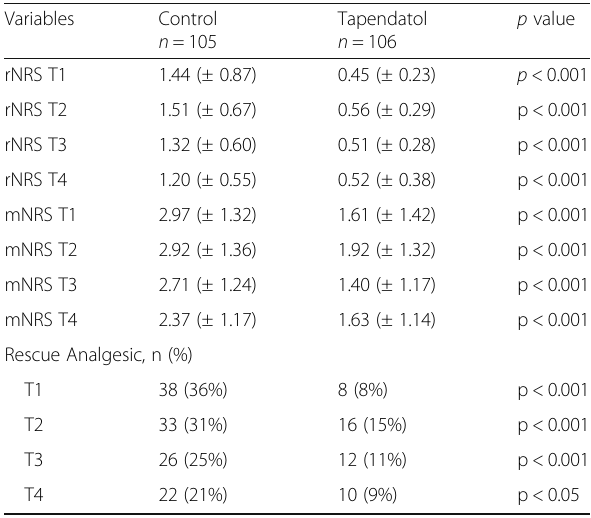
Table 1 Values of rNRS and mNRS in the two treatment groups at the various